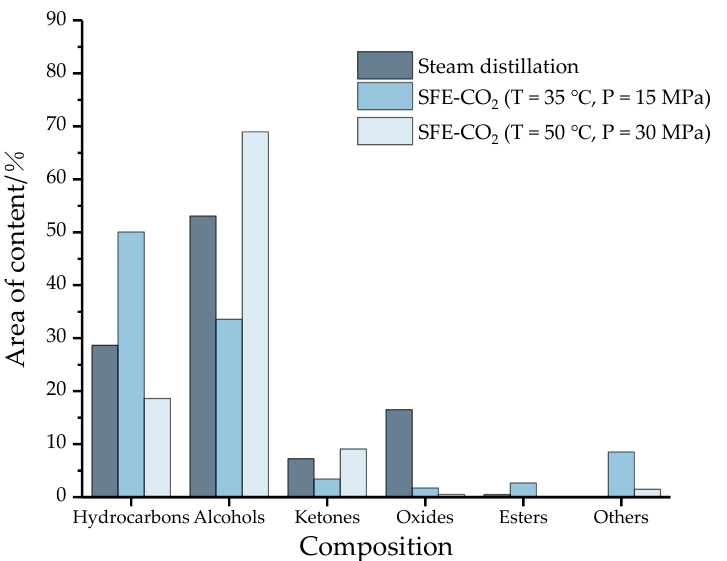
Figure 3. The chemical composition and area content of essential oil under three conditions (SFE-CO 2 : Supercritical carbon dioxide extraction; Others: ethers, aldehydes, phenols and acids).